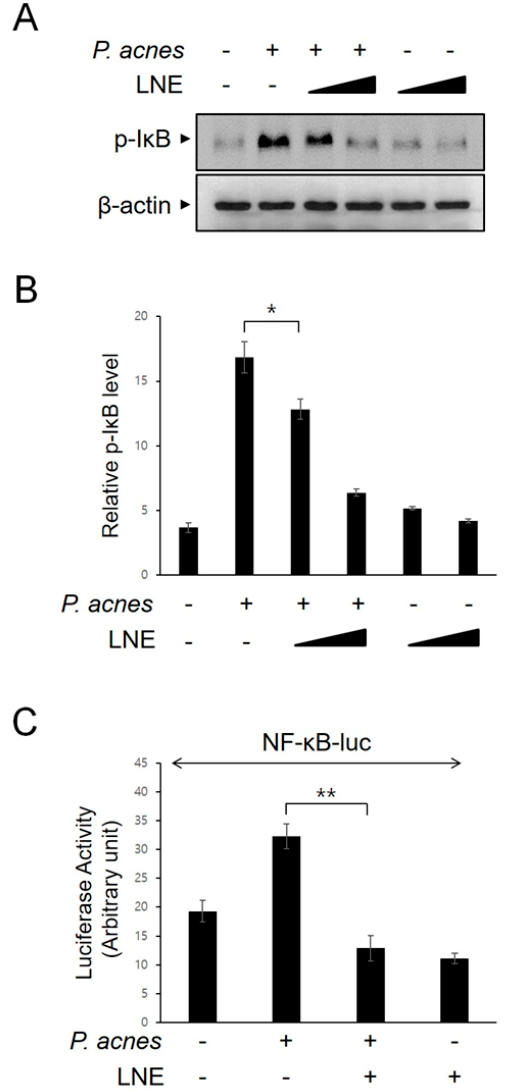
Figure 3. LNE inhibits the P. acnes -induced NF- κ B signaling pathways. ( A , B ) BMMs were treated with LNE (25 and 50 μ g/mL) for 30 min before P. acnes stimulation (1 × 10 7 CFU) for 6 h. Phospho-I κ B and GAPDH expression were detected by Western blot ( A ) and quantified ( B ). ( C ) The NF- κ B-luciferase construct (NF- κ B-Luc) was transfected into HEK293 cells and expressed for 24 h. The cells were treated with P. acnes (1 × 10 7 CFU) in the presence or absence of LNE (25 μ g/mL and 50 μ g/mL) for 12 h and then the luciferase activity was measured. * p < 0.05, ** p < 0.01.